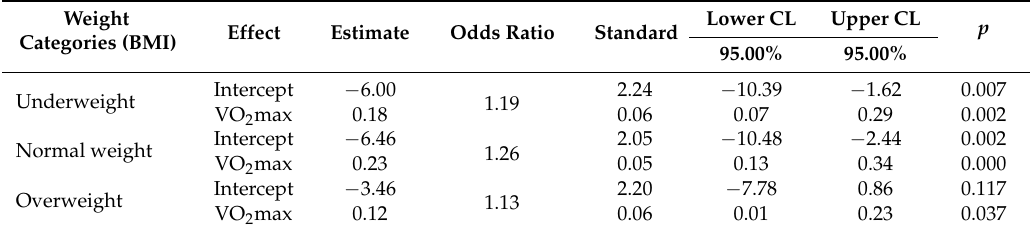
Table 6. Multinomial logit model results, where the independent variable was weight categories according to BMI and the continuous variable (predictor) was VO 2